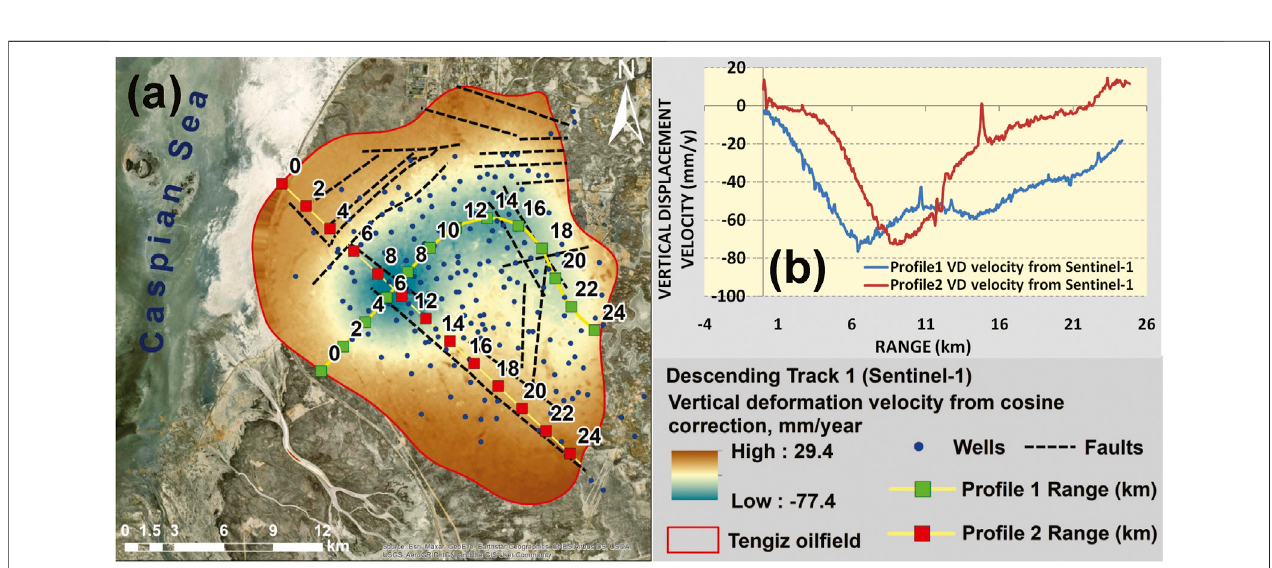
FIGURE 6 | (A) Map of vertical displacement velocity derived from the Sentinel-1 images with the indication of pro fi le lines; (B) pro fi le lines of vertical displacement velocities.